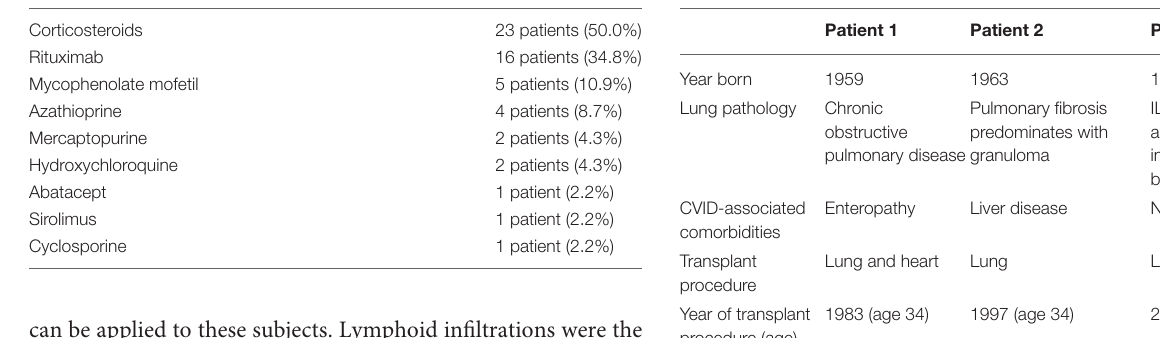
TABLE 5 | Lung transplant characteristics in this